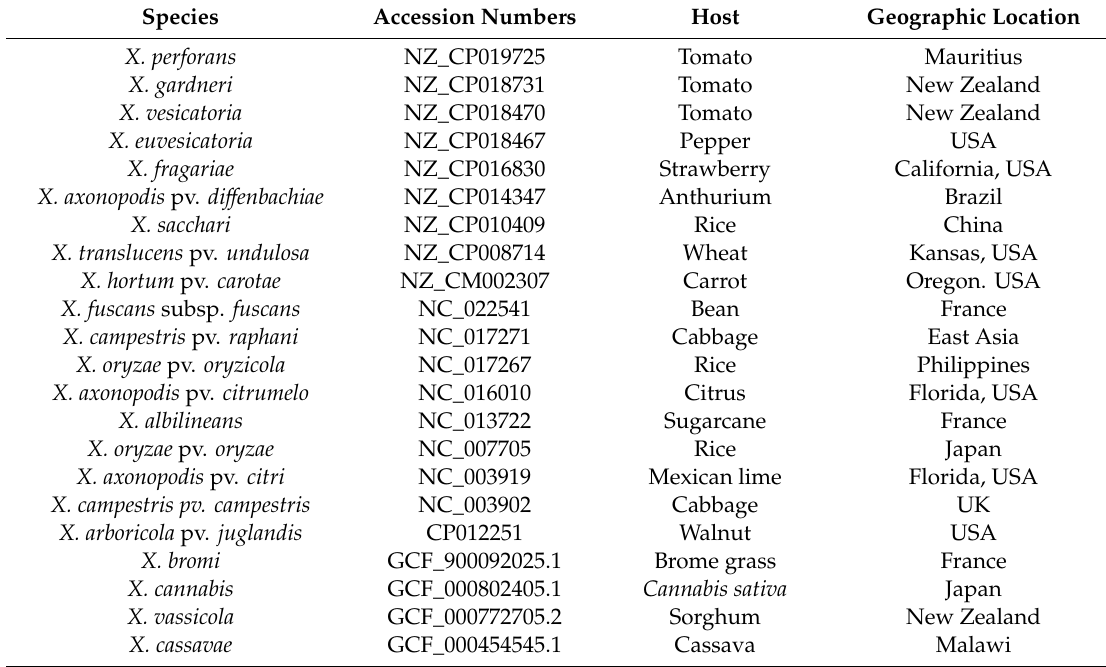
Table 3. Details of the xanthomonads genomes used to retrieve the gene sequences for phylogenetic analysis.